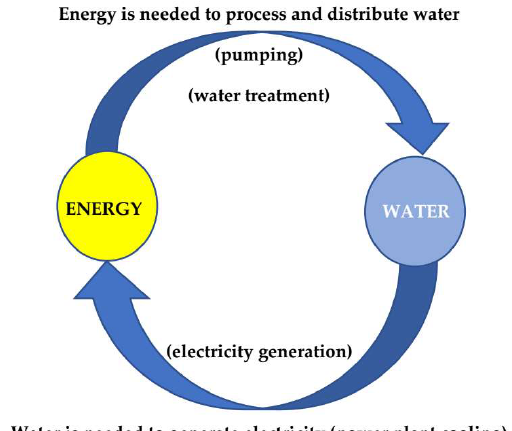
Figure 8. Energy–water nexus (adapted from Reference [11]).